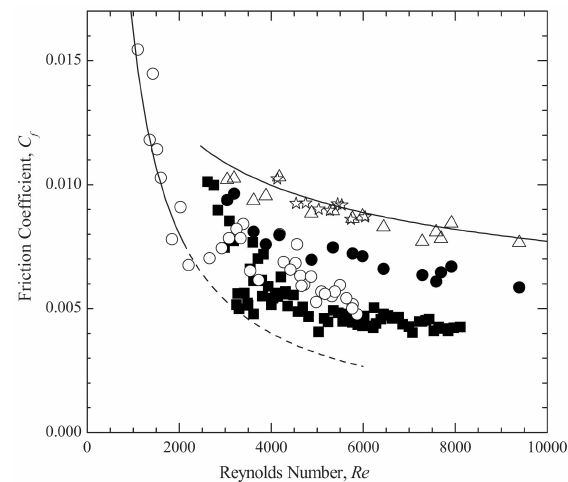
Figure 25. Skin-friction coefficient vs. Reynolds number. Measurements for microchannel with smooth surfaces (open triangles and open stars), with single superhydrophobic wall (solid circles), and with two superhydrophobic walls (open circles and solid squares). The theoretical predictions of the friction coefficient for a smooth channel are also shown (—). From Daniello et al.